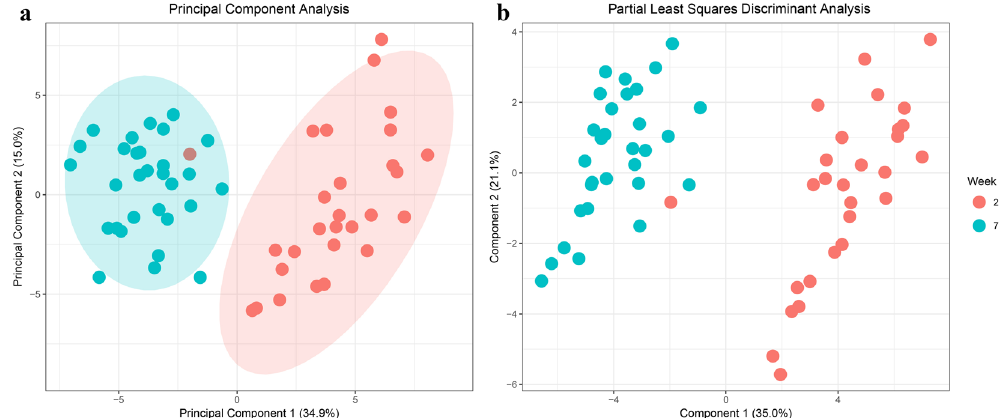
Figure 1. The combined data of milk metabolomics profiles and milk production traits were separated by lactation week in principal component analysis ( a ), and were further discriminated by lactation week with a discriminant power of Q 2 = 0.86 in partial least squares discriminant analysis ( b ). Numbers in parentheses is the percentage of explained variation of milk metabolites profiles and milk production traits due to separation between week 2 and week